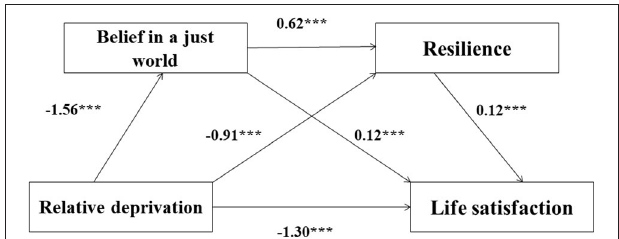
FIGURE 2 | The serial mediation model showed the effects of relative deprivation, belief in a just world, and resilience on life satisfaction. N = 787. Regression coefficients were obtained in PROCESS Procedure for SPSS. *** p <